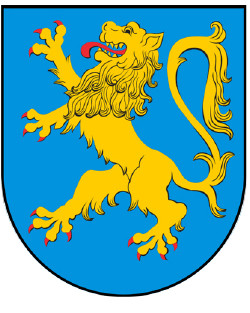
Figure 20. The former arms of Lwówek